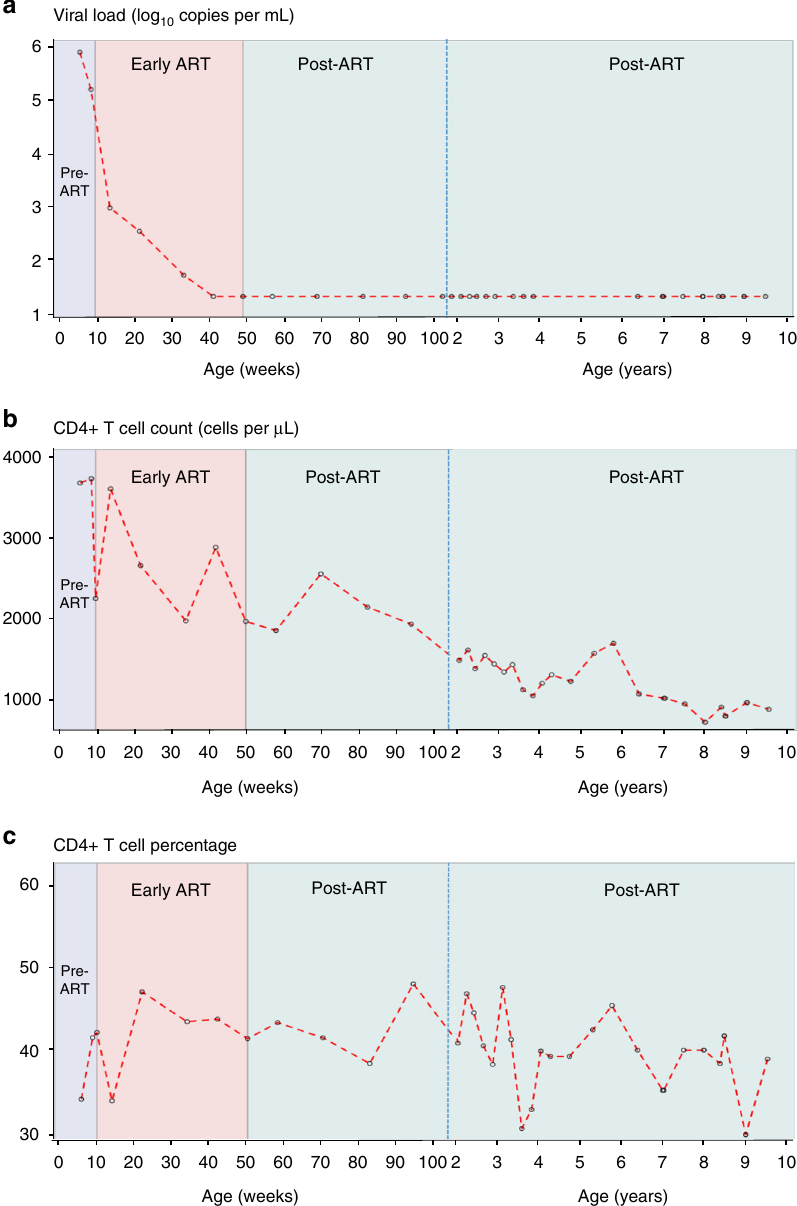
Fig. 1 Longitudinal viral loads and CD4 + T cell counts. a – c Viral load (log 10 RNA copies per mL) ( a ), absolute CD4 + T cell count (cells per µ L) ( b ) and CD4 + T cell percentage ( c ) are shown over time up to age 9.5 years (open circles joined by red dotted lines). Pre-ART, early ART and post-ART periods are indicated (shaded in lavender, pink, pale green, respectively). The X -axis shows age in weeks and then in years, separated by a blue vertical dotted line. Note: the detection limit of the VL assays used was 400 RNA copies per mL at 10.71 and 116.71 weeks; 50 RNA copies per mL at 33.71 weeks and 20 RNA copies per mL at all other time points. ART antiretroviral epitope (NLRTALR) of the α 1 helix 2 of the molecule — and therefore will bind to KIR3DL1 on NK cells. HLA- Cw*07:01:01 (allotype C1) and Cw*04:01:01 (C2) have a lysine (K) and asparagine (N) at position 80, respectively — allowing for inter- action with both KIR2DL3 (C1) and 2DL1 (C2) on NK cells. diverse interactions that may include engagement of CD4 and CD8 T cells and NK cells in antiviral responses.